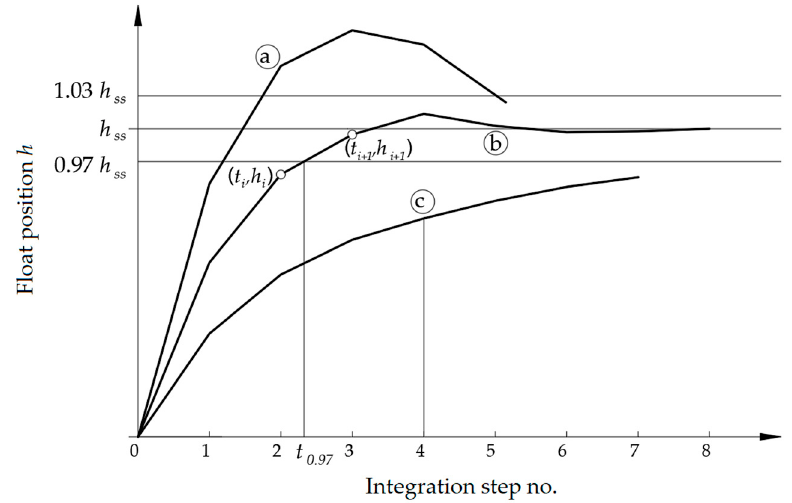
Figure 4. Definition of the objective function (graph not in a scale).